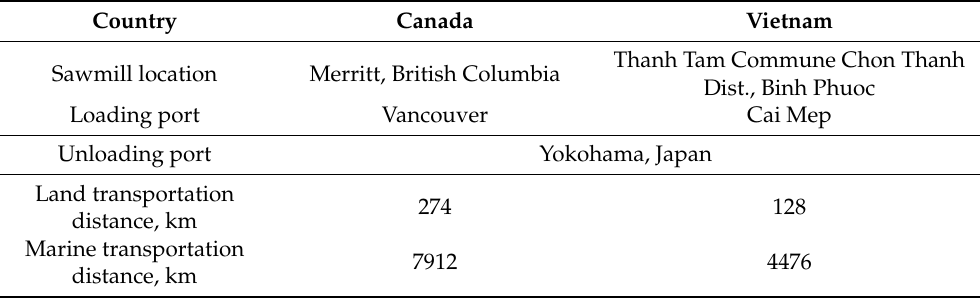
Table 1. Fuel production sites in Canada and Vietnam and specifications of transportation to Japan.